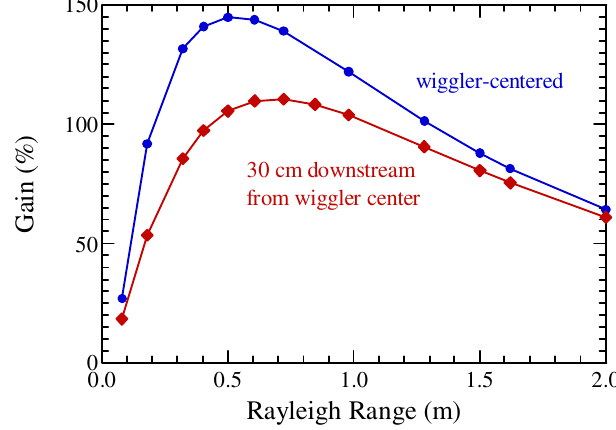
FIG. 7. (Color) Variation of the single pass gain with the Rayleigh range.